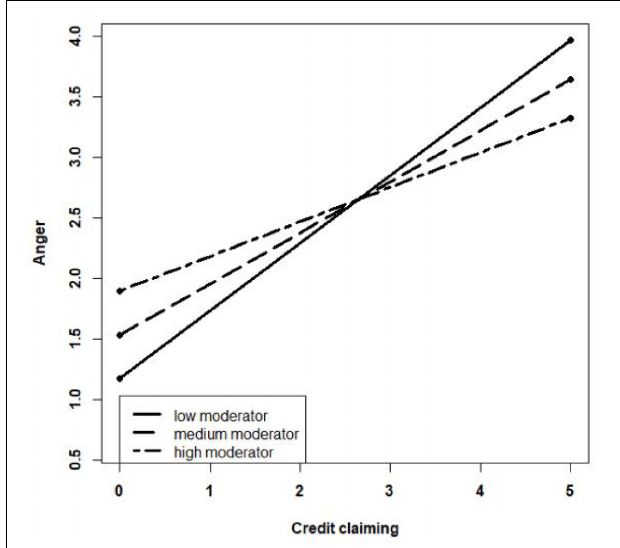
FIGURE 2 | Moderating effect of credit-claiming attribution to protect employees on the relationship between leaders’ credit claiming and employees’